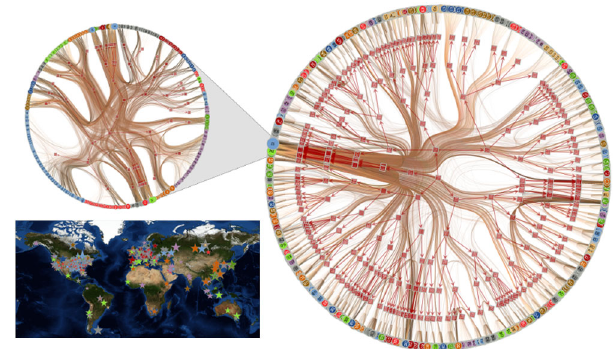
FIG. 6. Large-scale structure of the Internet at the autonomous systems level, as obtained by the nested stochastic block model, displaying a prominent core-periphery architecture. The magni- fication shows the nodes that belong to the “ core ” top-level branch, containing AS nodes spread all over the globe, as shown in the map inset. See the Supplemental Material [96] for a higher- resolution version of this figure.